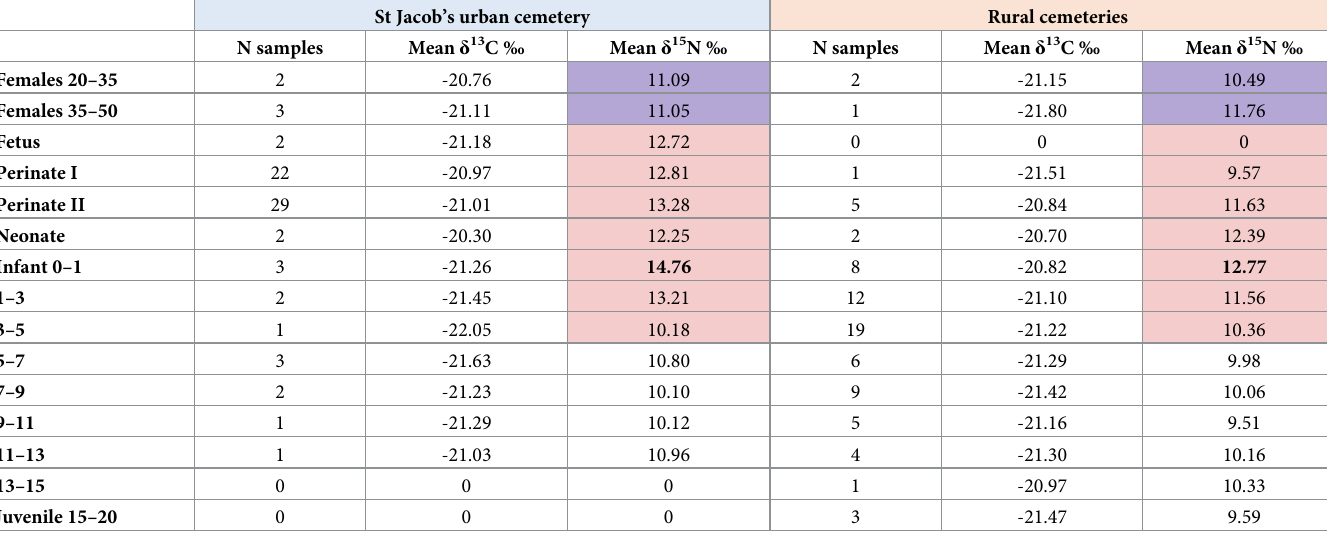
Table 3. Summary statistics of non-adult isotopic values for each